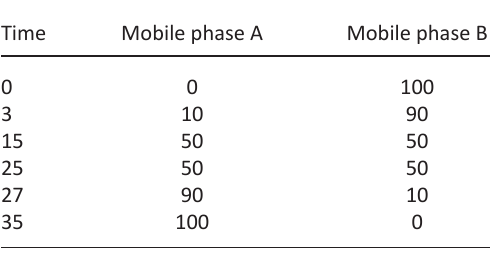
Table 1. Gradient elution